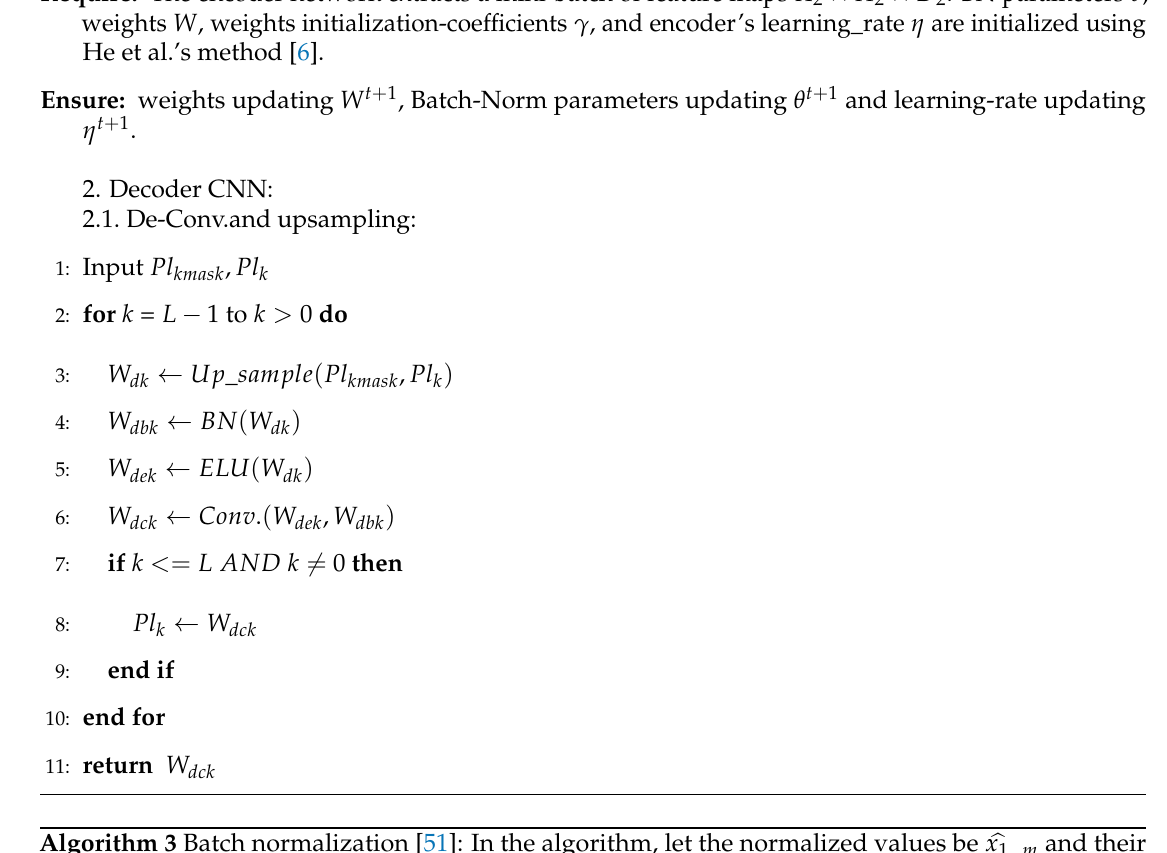
Algorithm 2 CNN decoder training: Input pooling mask size of X 2 × H 2 × D 2 . The out volume is X D × H D × D D .